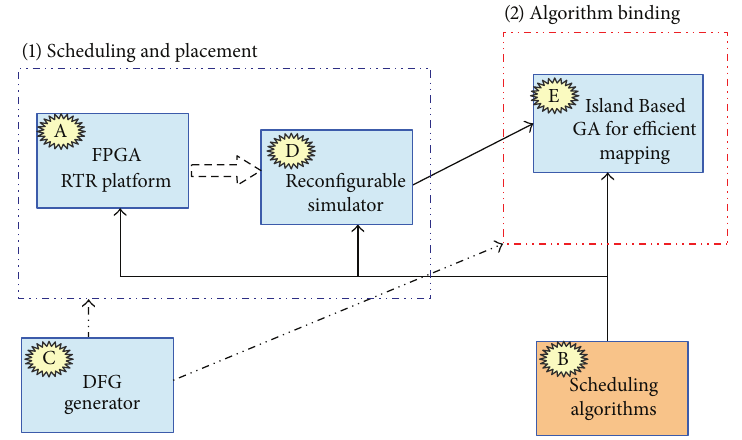
Figure 3: Overall